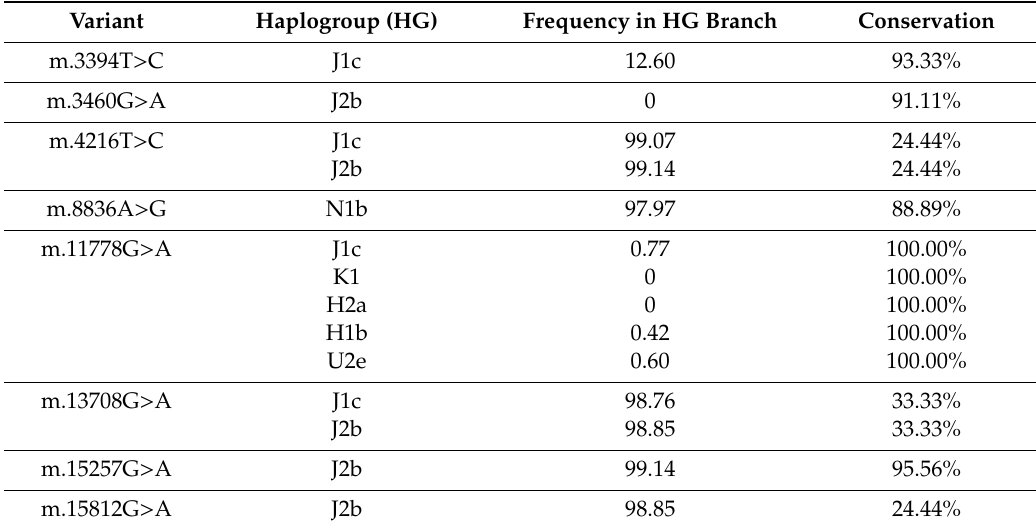
Table 3. Sub-haplogroups characterization of the detected